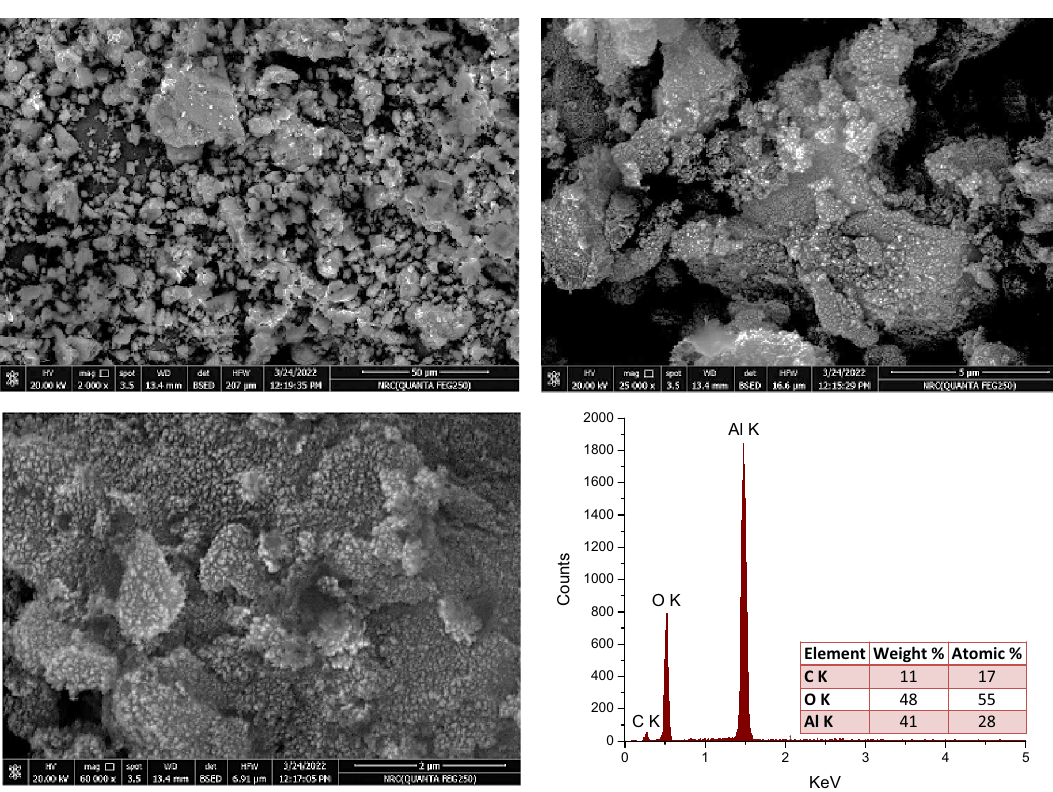
Figure 5. SEM micrographs at various magnifications and EDX analysis of fabricated mesoporous γ-Al 2 O 3